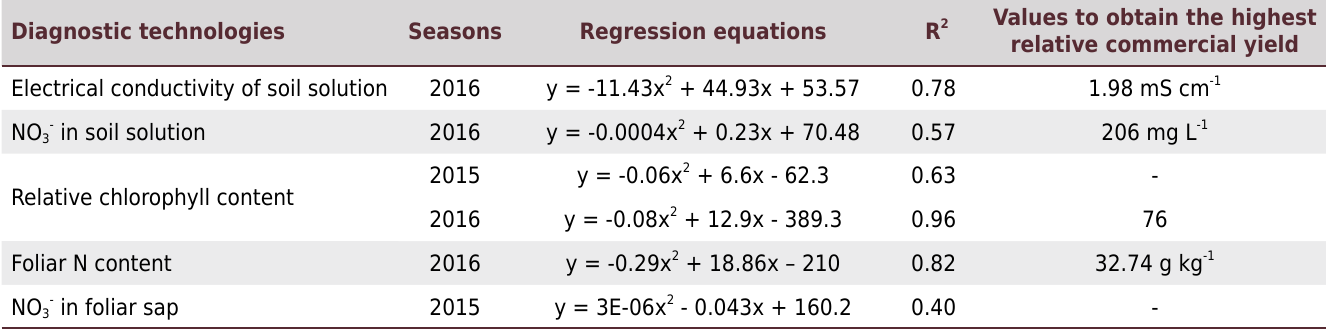
Table 3. Relationship between the values of the critical level of nitrogen in the leaf and the relative yield of virus-free garlic bulbs in two agricultural growing seasons Diagnostic